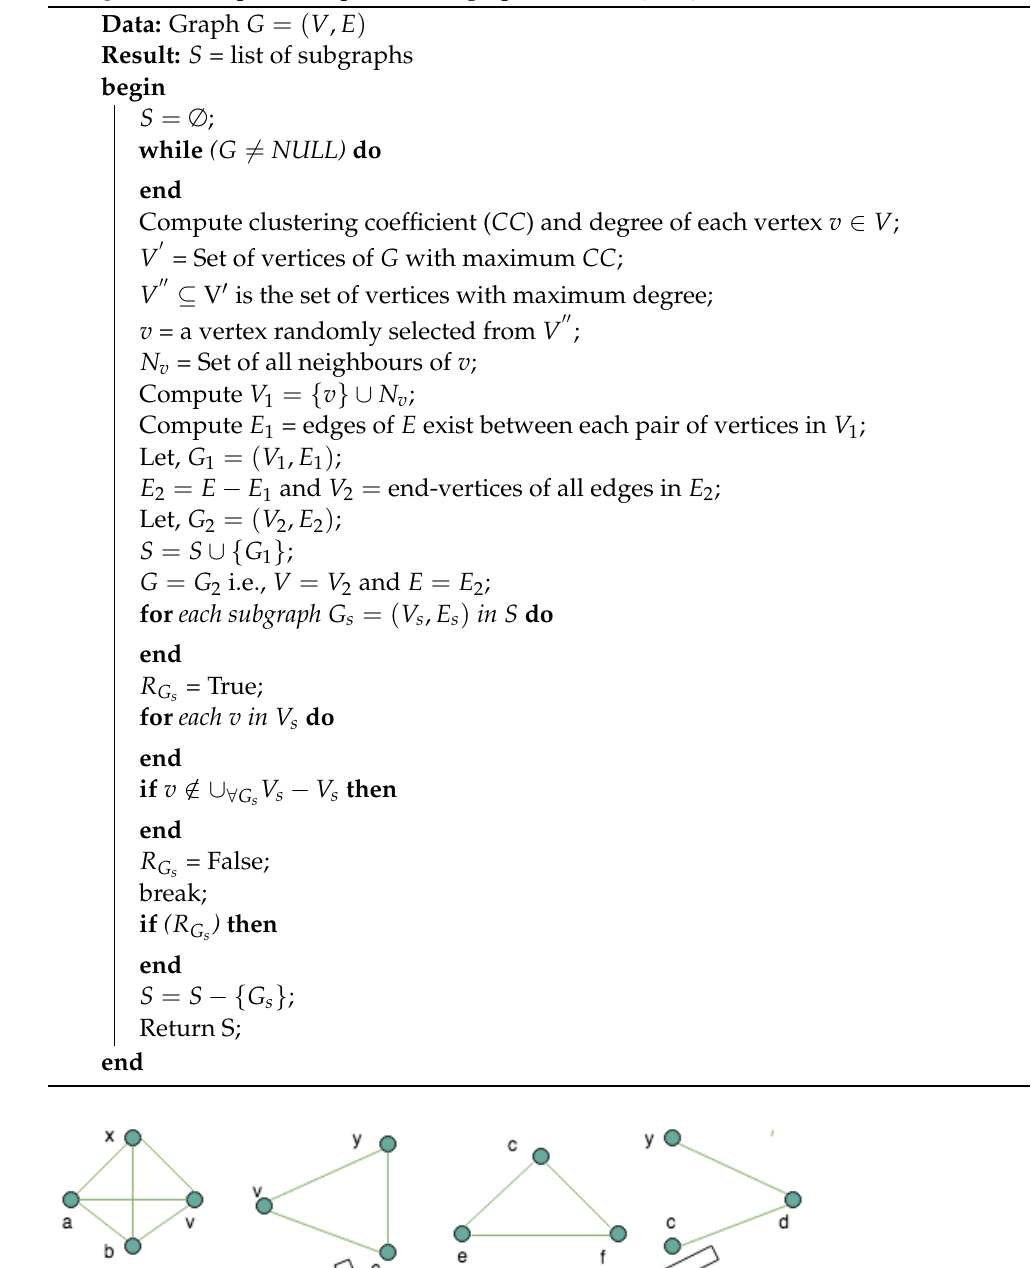
Algorithm 1: Split a Graph into subgraphs - SPLIT ( G , S )